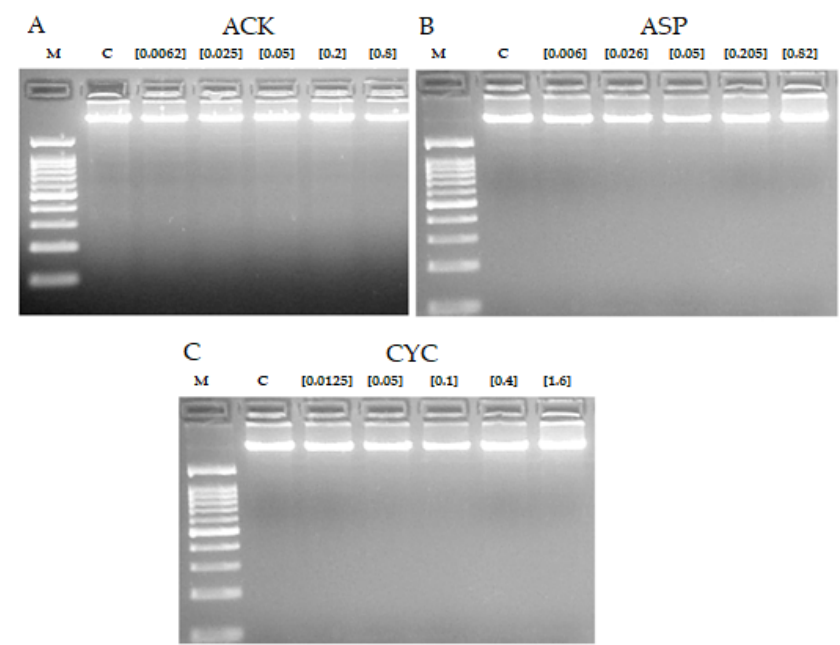
Figure 3. Internucleosomal DNA fragmentation after 5 h of treatment with ACK ( A ), ASP ( B ) and CYC ( C ). Letters M and C mean weight size marker and negative control, respectively.